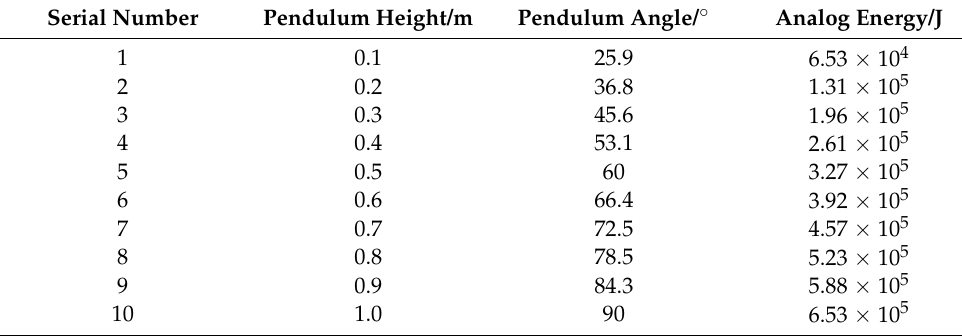
Table 2. Pendulum position and simulated